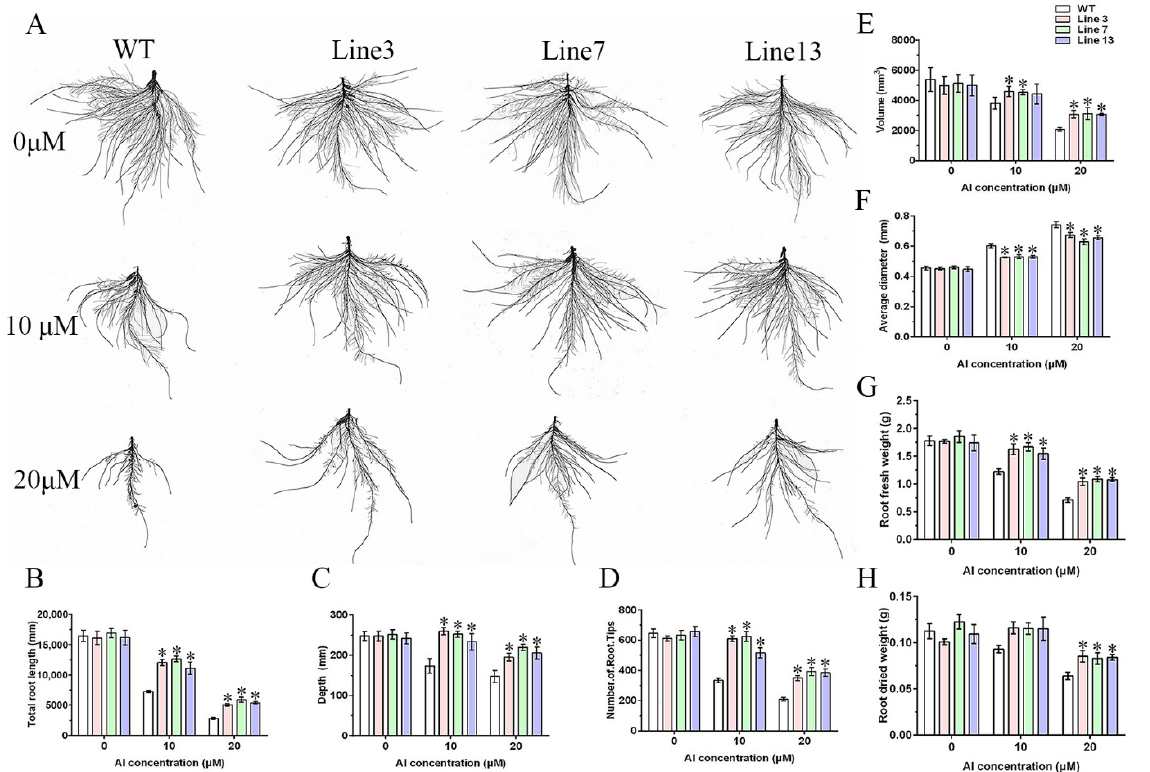
elongation of different lines in different treatments/root elongation of WT in treatment with 0 μ M AlCl 3 * 100%. WT: wild type (Guixia1, Al-sensitive). Line 3, Line 7 and Line 13: GmWRKY81 trans- genic lines. Asterisks denote significant differences: p < 0.05. The data are presented as the means ± SD from three biological replicates, and each biological replicate included 4 plants.